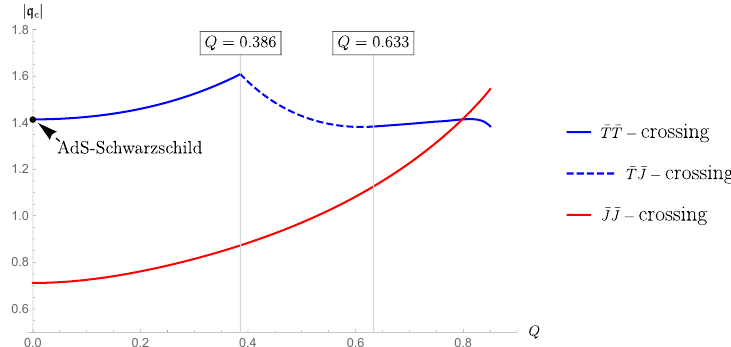
Figure 7. The radius of convergence of the derivative expansion versus Q . As Q increases, the radius of convergence of w di(cid:11)usion (red curve) monotonically increases. At the same time, domain of convergence of w sound non-trivially changes. As discussed in the text, it can be studied in three di(cid:11)erent intervals: 0 (cid:20) Q (cid:20) 0 : 386, 0 : 386 (cid:20) Q (cid:20) 633 and 0 : 633 (cid:20) Q (cid:20) 0 : 850. The intersection point of blue curve with the vertical axis, related to the sound mode in the N = 4 SYM theory in the vanishing (cid:22) limit, was found in